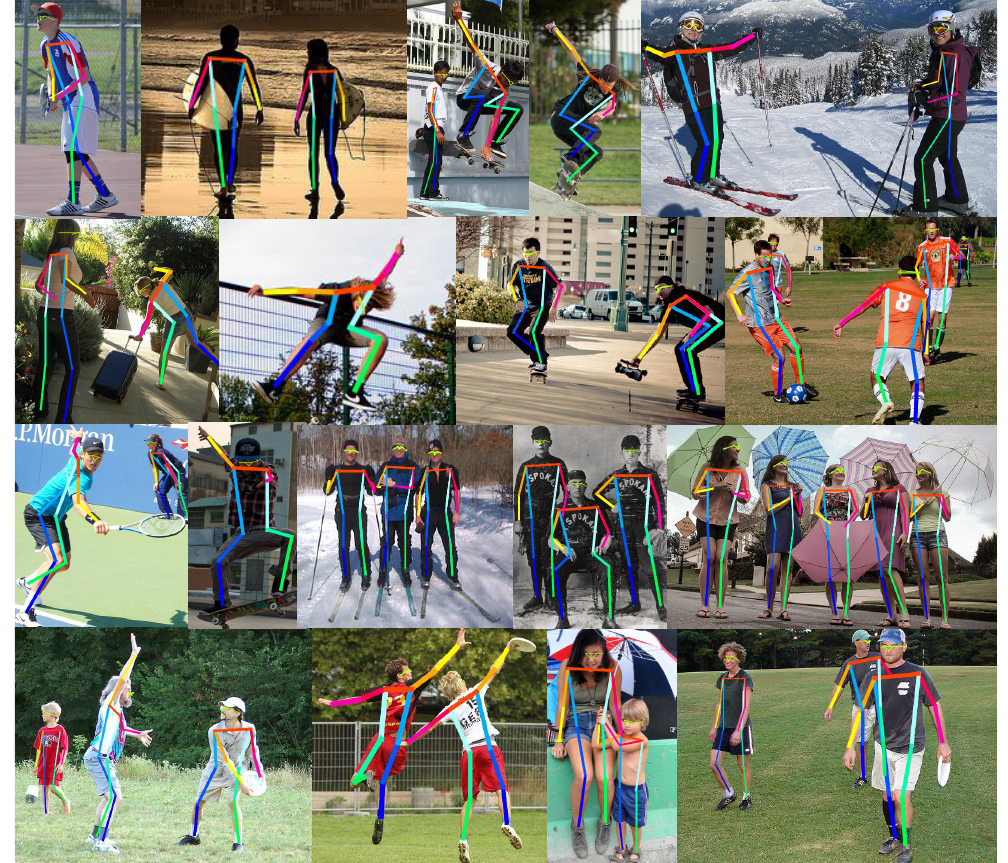
Figure 10. Sample results on the COCO